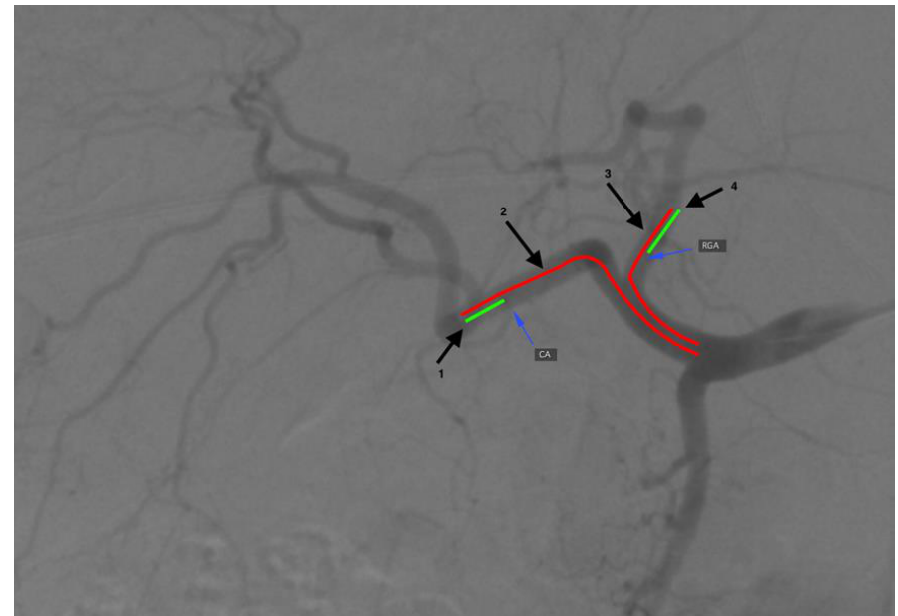
Figure 1. A general scheme presenting the measurement procedure. Thin arrows indicate origins of the cystic artery (CA) and the right gastric artery (RGA). Numbers at thick arrows (1 – 4) indicate distances (lines) of the tip of the microcatheter from the cystic artery, the gastroduodenal artery (for right lobe injection), the gastroduodenal artery (for left lobe injection), and the right gastric artery, consecutively.